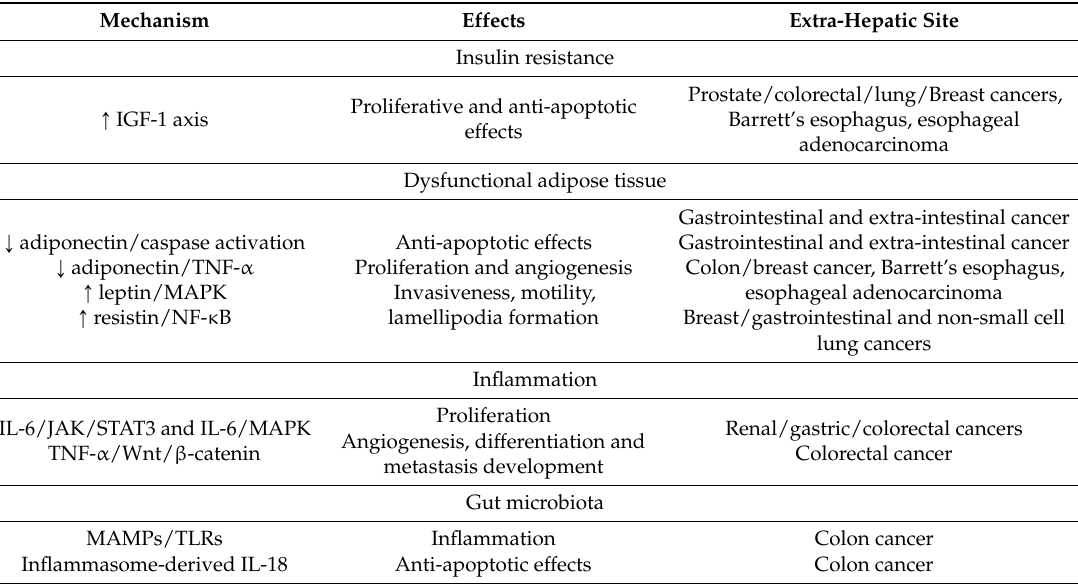
Table 2. Putative mechanisms linking NAFLD and extra-hepatic